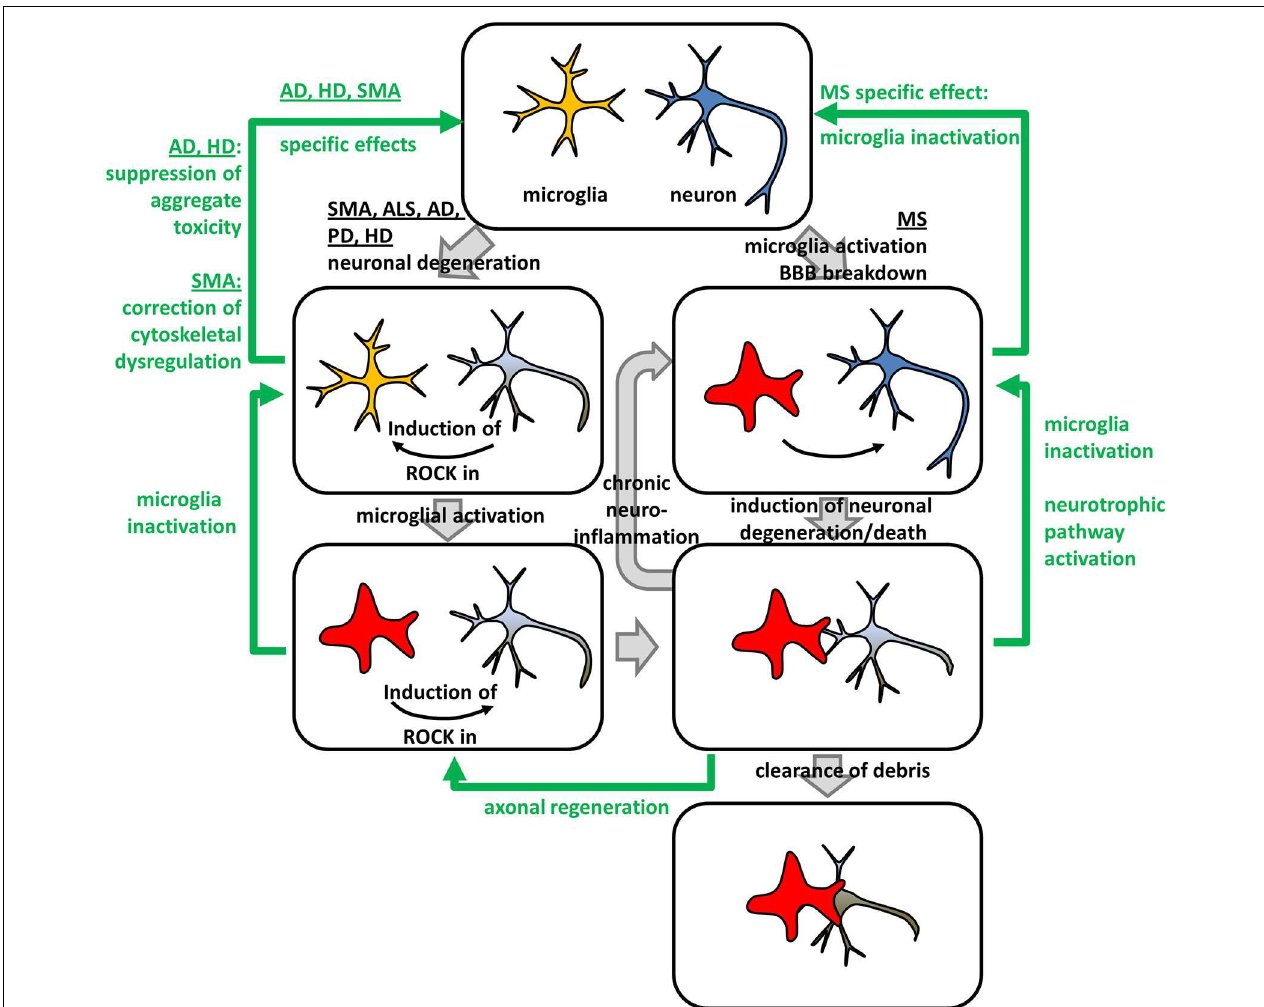
FIGURE 2 | Beneficial effects of ROCK-inhibition in neurodegeneration – an integrated model. Neurodegenerative and neuroinflammatory processes (gray arrows) in different NDDs and in multiple sclerosis (MS) can be reversed by ROCK-inhibition (green arrows). Neuronal degeneration in Spinal Muscular Atrophy (SMA), Amyotrophic Lateral Sclerosis (ALS), Alzheimer’s Disease (AD),